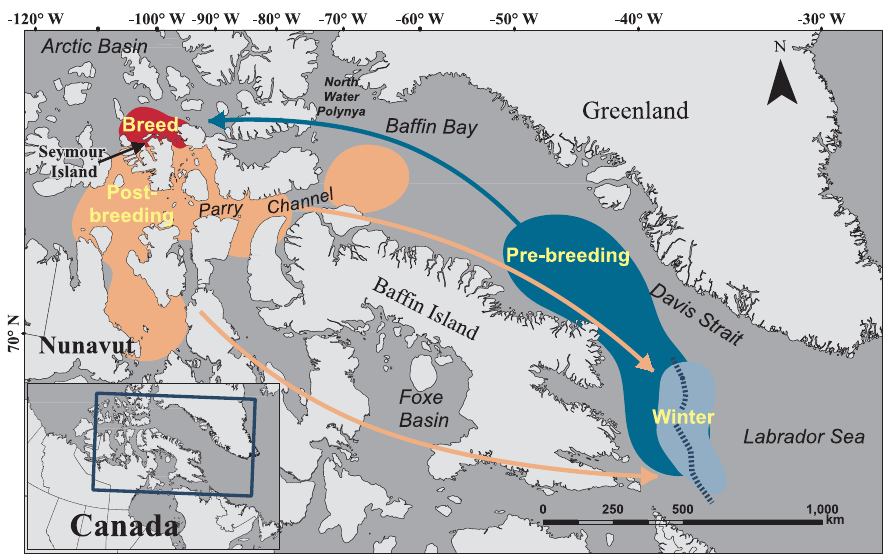
Fig. 1. Annual distribution of the Canadian ivory gull. The 50% kernels represent distribution during breeding (red), post-breeding (orange), winter (light blue) and pre-breeding seasons (dark blue). General direction of post-breeding migration is indicated by the arrows (south via Davis Strait and Foxe Basin in orange) from ’post-breeding’ to ’winter’ and direction of pre-breeding migration is indicated by the arrow (north via Davis Strait in blue) from ’pre-breeding’ to ’breed. The dashed line through the winter kernel represents a composite of the typical edge of the pack ice, 2010-2013, from December through